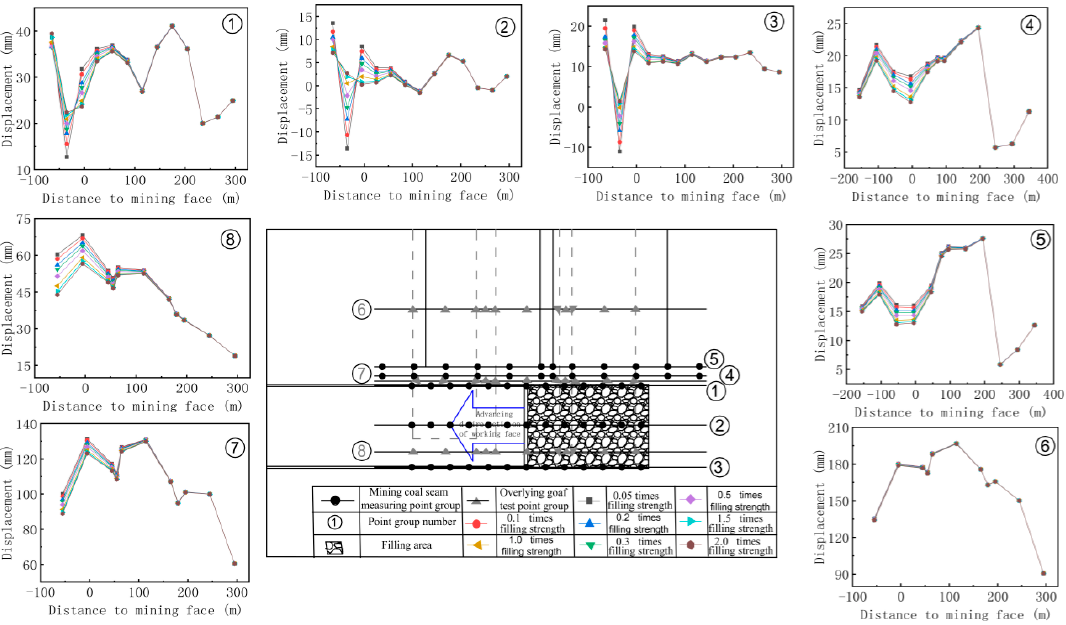
Minerals 2018 , 8 , x FOR PEER REVIEW Figure A1. Movement characteristics of coal and rock strata (60 m). Figure A1. Movement characteristics of coal and rock strata (60 m).